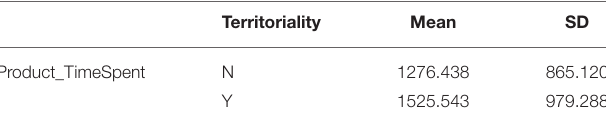
TABLE 2 | Descriptive statistics of Product Time Spent in relation to territoriality.